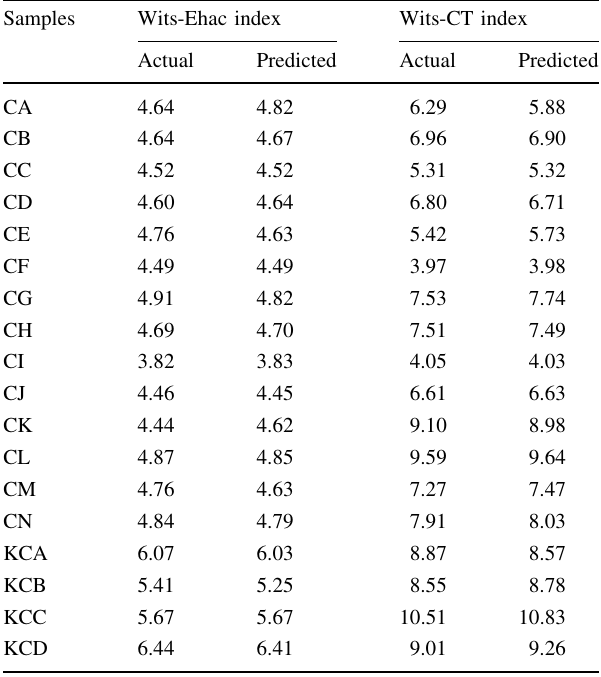
Table 8 Predictive formulas derived by multiple regression analysis Model no.